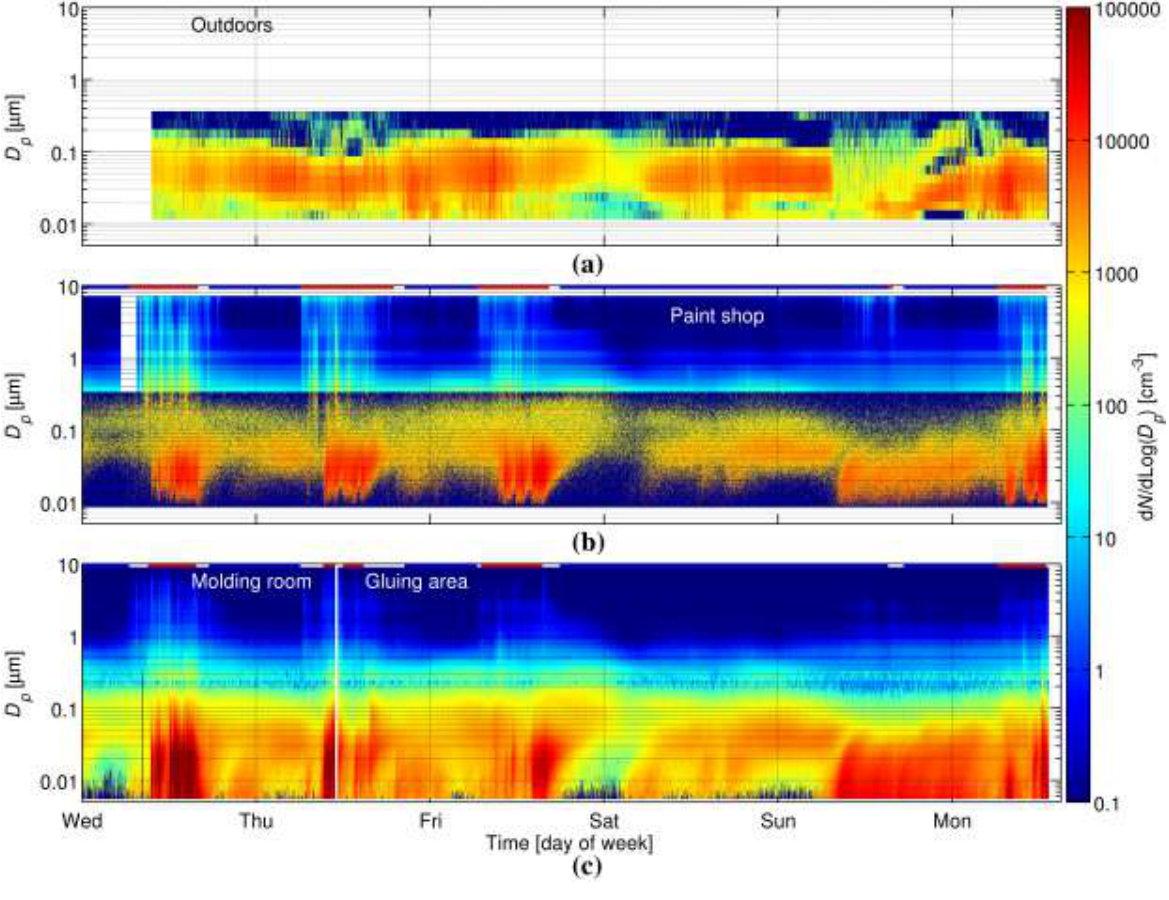
Figure 4. Particle size distribution time series. ( a ) Outdoors measured by NanoScan, ( b ) in the paint shop measured by SMPS and OPS, and ( c ) in the molding room (Tuesday 16:14–Thursday 11:04) and the gluing area (Thursday 11:07–Monday 13:20) measured by SMPS + C and DM). In figure ( b ) and ( c ) horizontal red lines shows the working hours in the respective locations and blue lines non-working